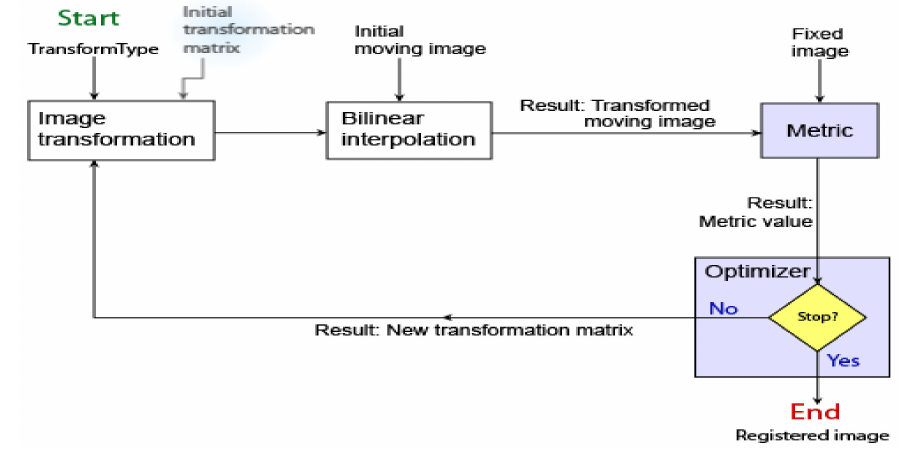
Figure 11. Intensity-based image registration algorithm flowchart [48].